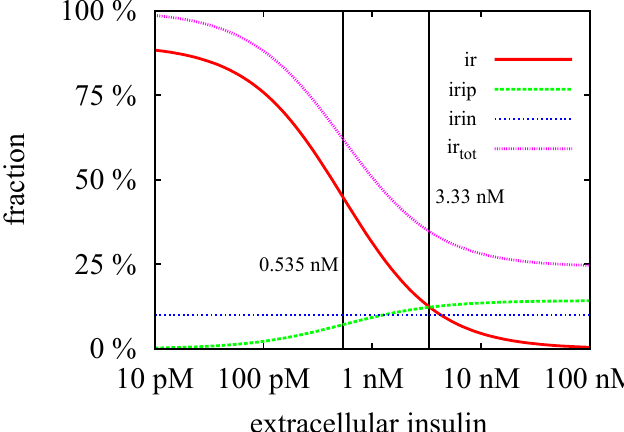
Figure 10. The steady-state concentrations, ir † (red line), irip † (green line), ir † = ir † + irip † + ir † and ir (violet line) are plotted versus the external insulin concentration tot in i 0